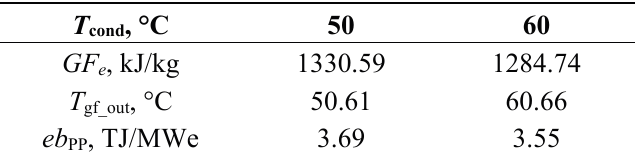
Table 4. The effect of the condensing temperature T cond of the air-cooled double-expansion plant for T gf_in = 700 °C and P gf_in = 23